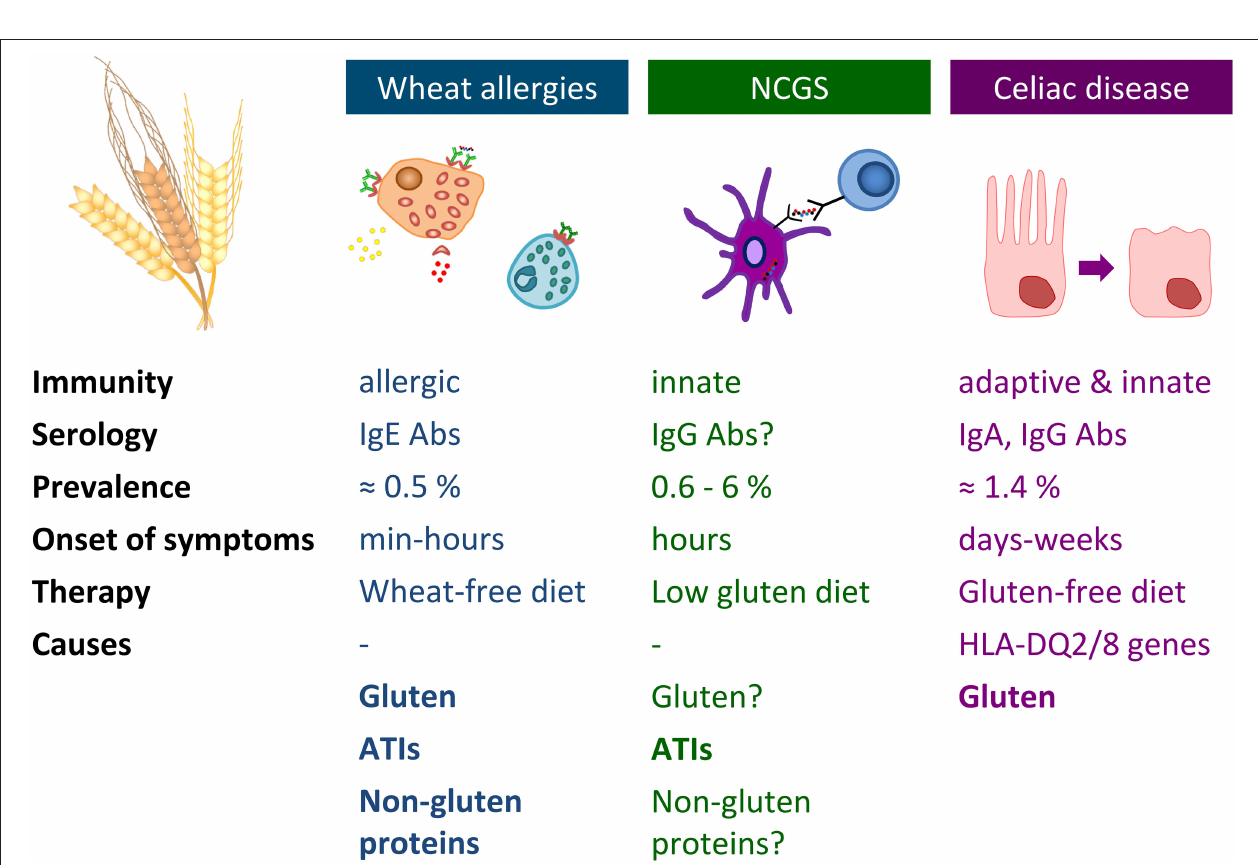
FIGURE 2 | Overview of wheat allergy, non-celiac gluten sensitivity, and celiac disease. Abs, antibodies; ATIs, α -amylase/trypsin-inhibitors; HLA, human leukocyte antigen; Ig, immunoglobulin; NCGS, non-celiac gluten sensitivity.